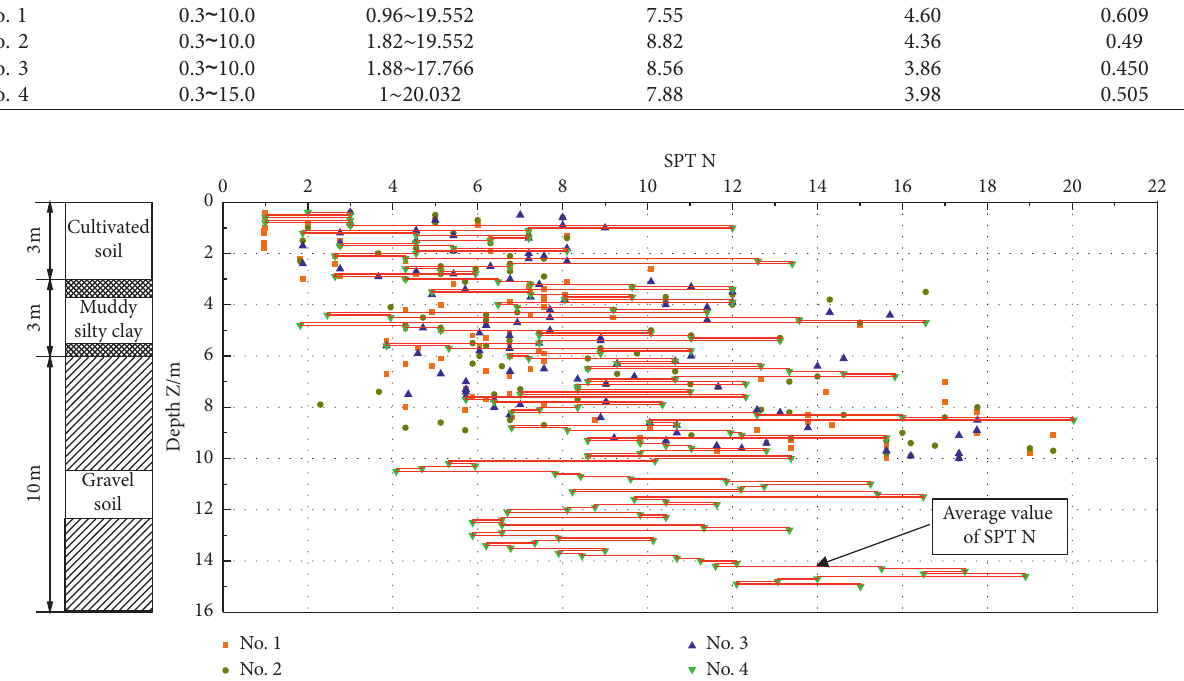
Table 1: Statistical table of test indexes of superheavy dynamic sounding test (N